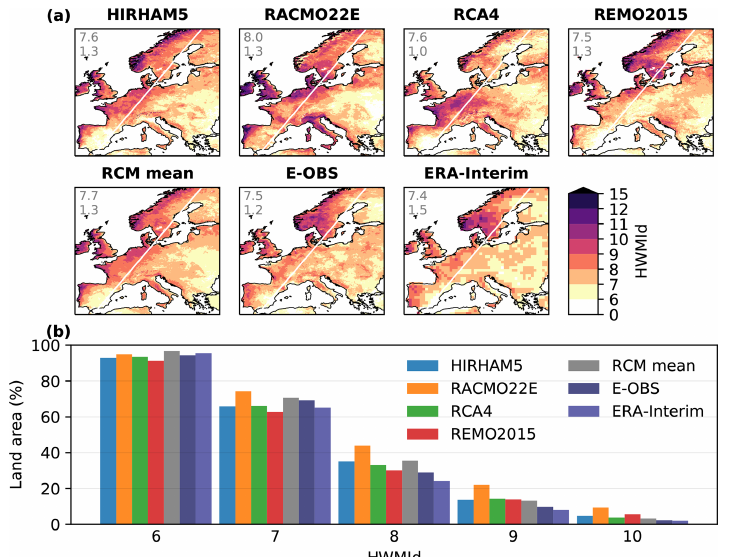
Figure 1. Climatological mean HWMId over 1989–2008 in the four RCM evaluation runs, the multi-RCM mean, E-OBS, and ERA-Interim: (a) spatial pattern, and (b) percentage of the land area exceeding certain HWMId levels (HWMId ≥ 6, 7, 8, 9, or 10). The two numerals in each map show the area-weighted average over the entire domain and the difference between western and eastern parts divided by the white line. Table 2. Spatial MBE, RMSE, and r for the climatological mean HWMId over 1989–2008 in ERA-Interim, the four RCM evaluation runs, and the multi-RCM mean (corresponding to Fig. 1), with E-OBS as reference. ERA-Interim HIRHAM5 RACMO22E RCA4 REMO2015 RCM mean MBE − 0.13 0.12 RMSE 0.55